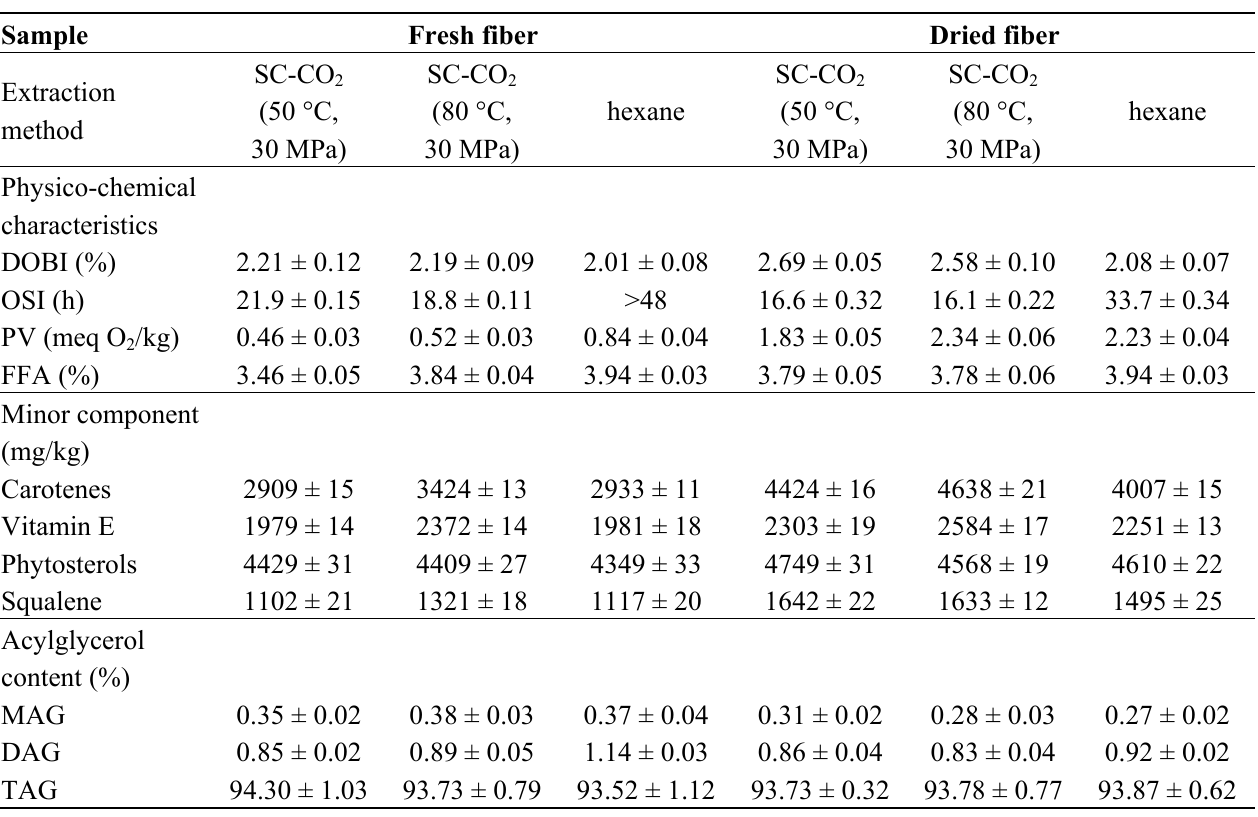
Table 5. The physico-chemical characteristics, minor components and acylglycerol contents in the SC-CO and hexane extracted palm fiber oil a . Reproduced with substantial 2 modification from